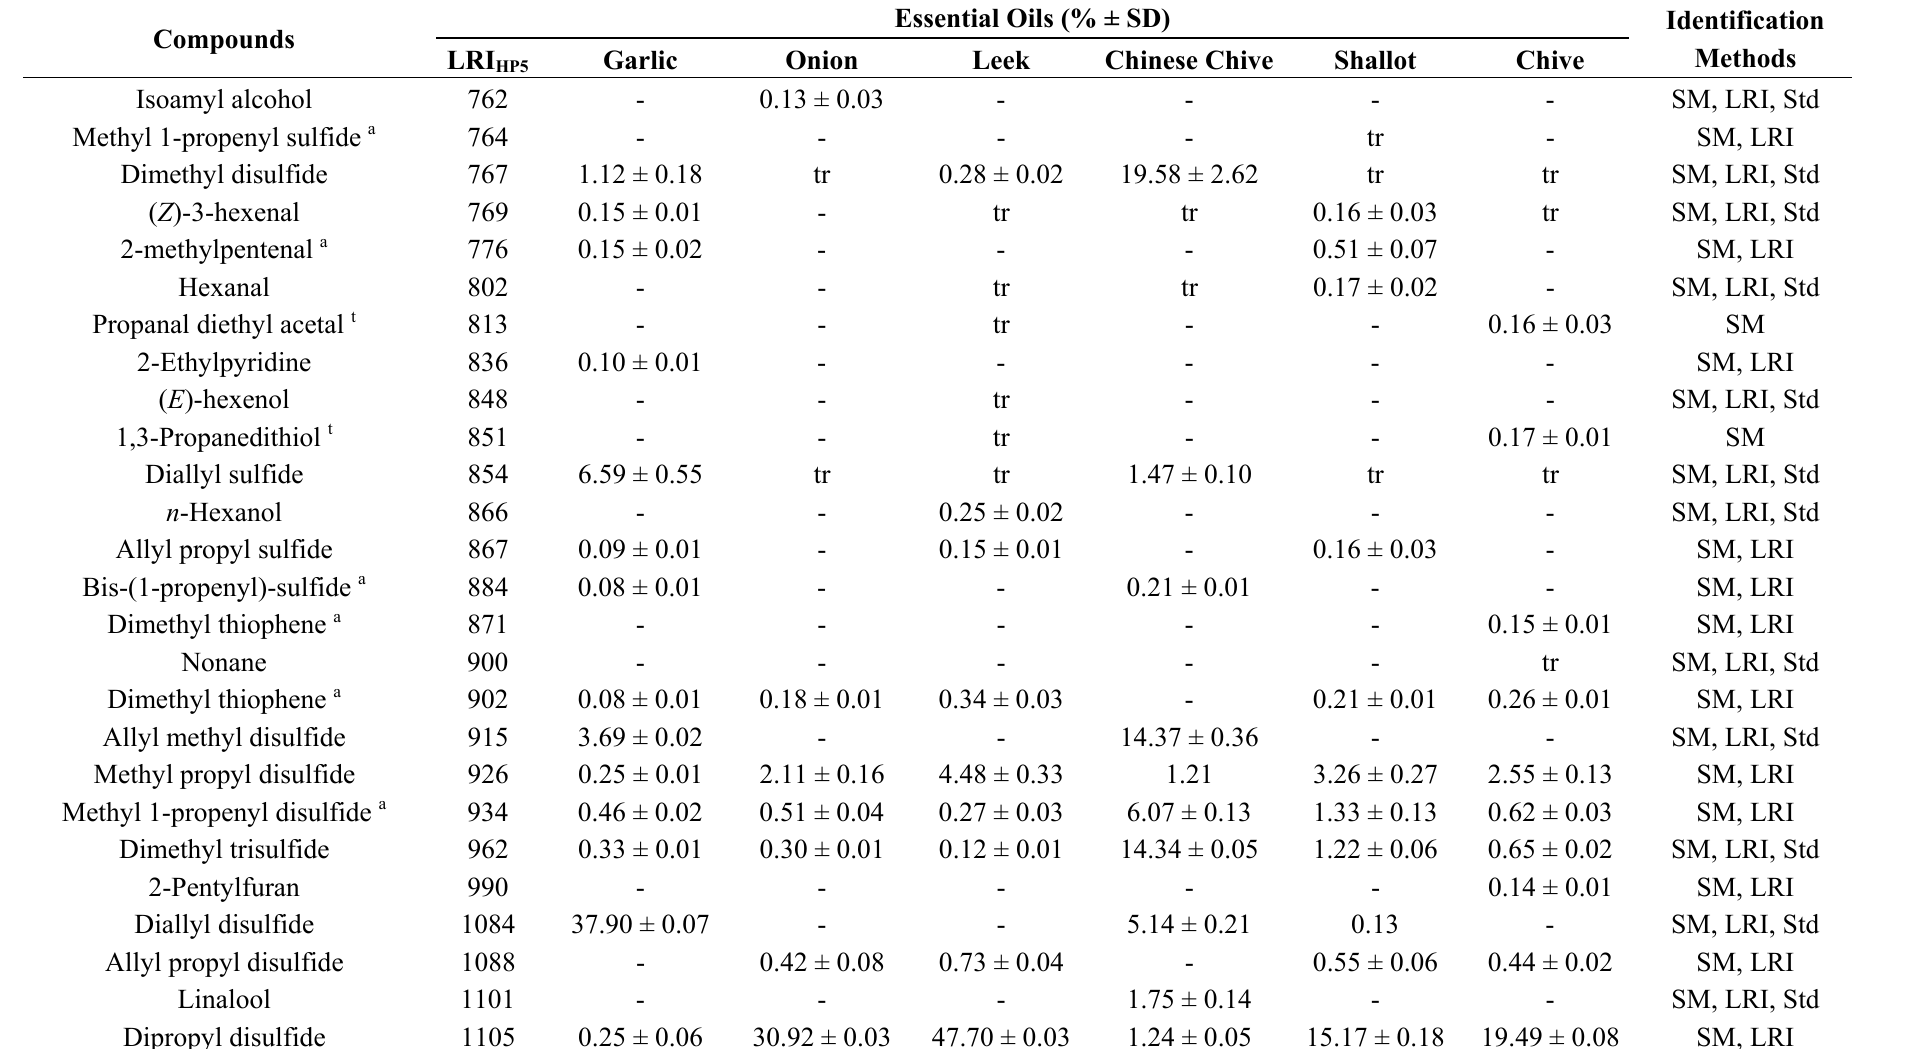
Table 1. Chemical composition of the essential oils of garlic, onion, leek, Chinese chive, shallot and